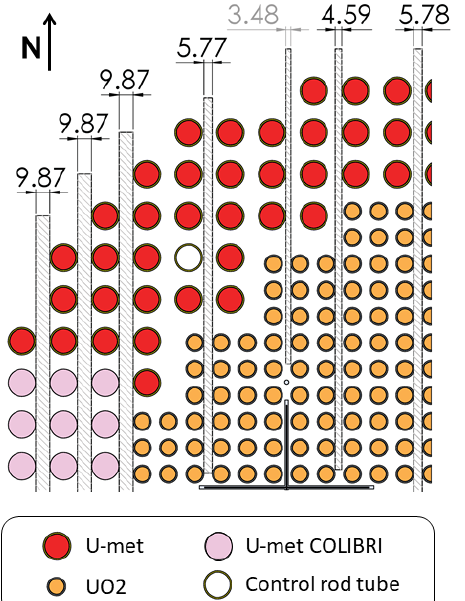
Fig. 3. North-west portion of the horizontal section of the CROCUS reactor with indication of the locations available to cross in a straight line the double fuel lattice. The maximum space available for the crossing is indicated in mm.